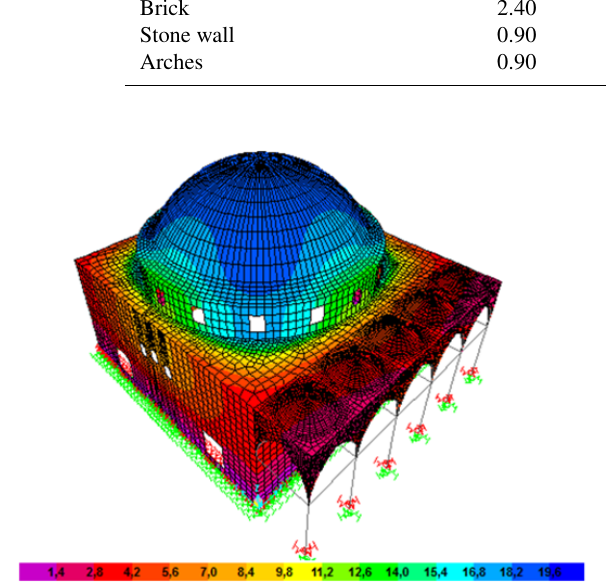
Figure 13. Maximum displacements contour diagram of the mosque with 16 window openings under dead load and earthquake load in the z direction (G +